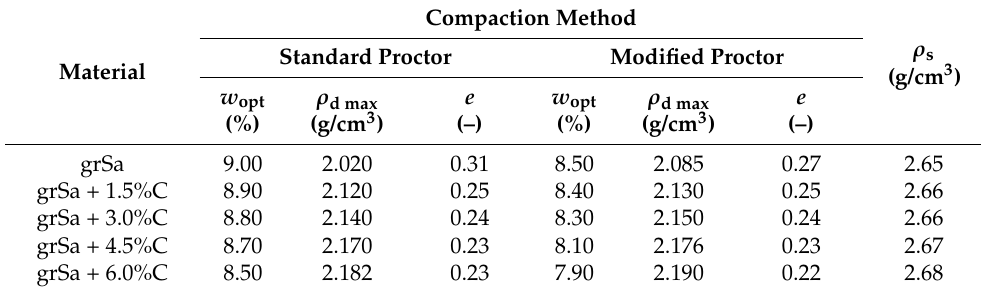
Table 1. Geotechnical properties of tested